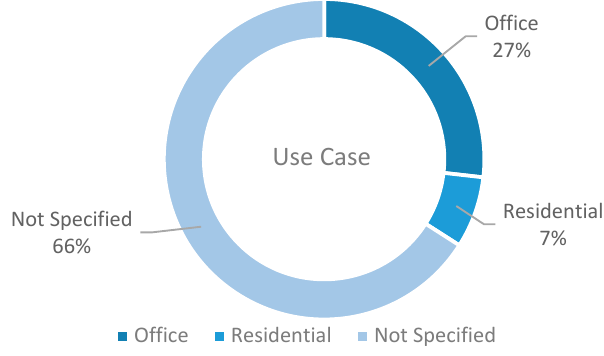
Figure 4. Building usage types of the ADBE systems.